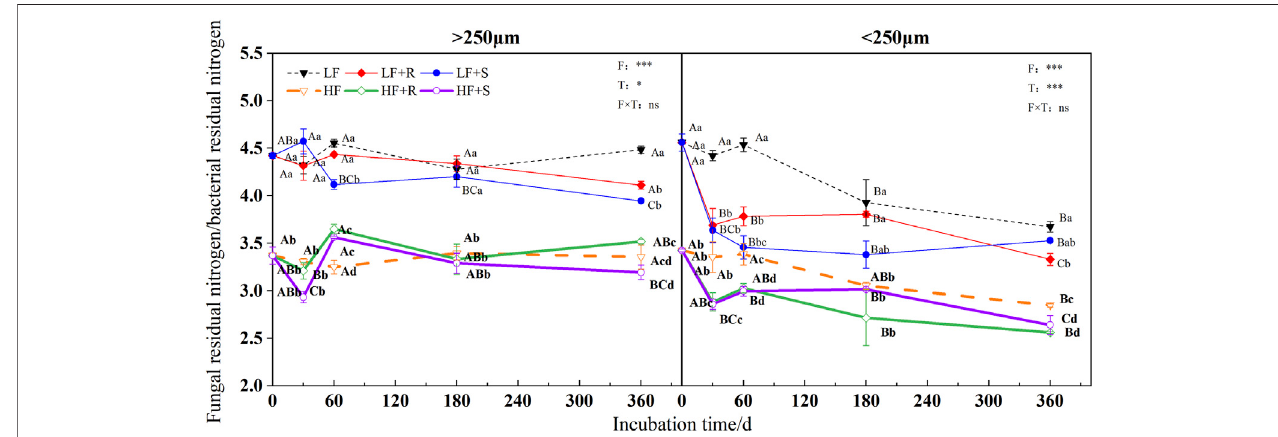
FIGURE8| Ratio offungal tobacterial residualnitrogen insoil aggregates with differentfertility levels after theaddition ofdifferentparts ofmaize residues. Note: LF meanslowfertility,LF+Rmeanslowfertility+roots,andLF+Smeanslowfertility+Shoots;HFmeanshighfertility,HF+Rmeanshighfertility+roots,andHF+Smeans high fertility + Shoots. Uppercase letters represent differences between different periods in the same treatment, and lowercase letters represent differences between different treatments at the same period. For the ANOVA, F means fertility level, T means the type of maize residues, and F × T means fertility level × type of maize residues. *,**, and *** mean p < 0.05, 0.01, and 0.001, respectively. ns means no signi fi